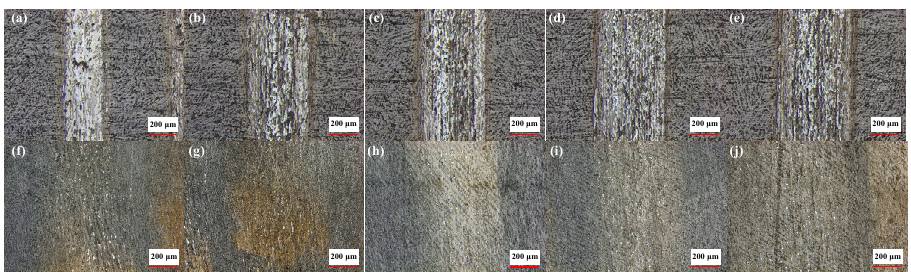
Figure 10. Wear scar morphology of 25 wt. % initial solids phase content composites at 3 N under dry friction conditions with speed of: ( a ) 100 r/min; ( b )150 r/min; ( c ) 200 r/min; ( d ) 250 r/min; and ( e ) 300 r/min. Wear scar morphology of 25 wt. % initial solids phase content composites at 3N under water-based drilling fluid conditions with speed of: ( f ) 100 r/min; ( g ) 150 r/min; ( h ) 200 r/min; ( i ) 250 r/min; and ( j ) 300 r/min. Materials 2018 , 11 , x FOR PEER REVIEW